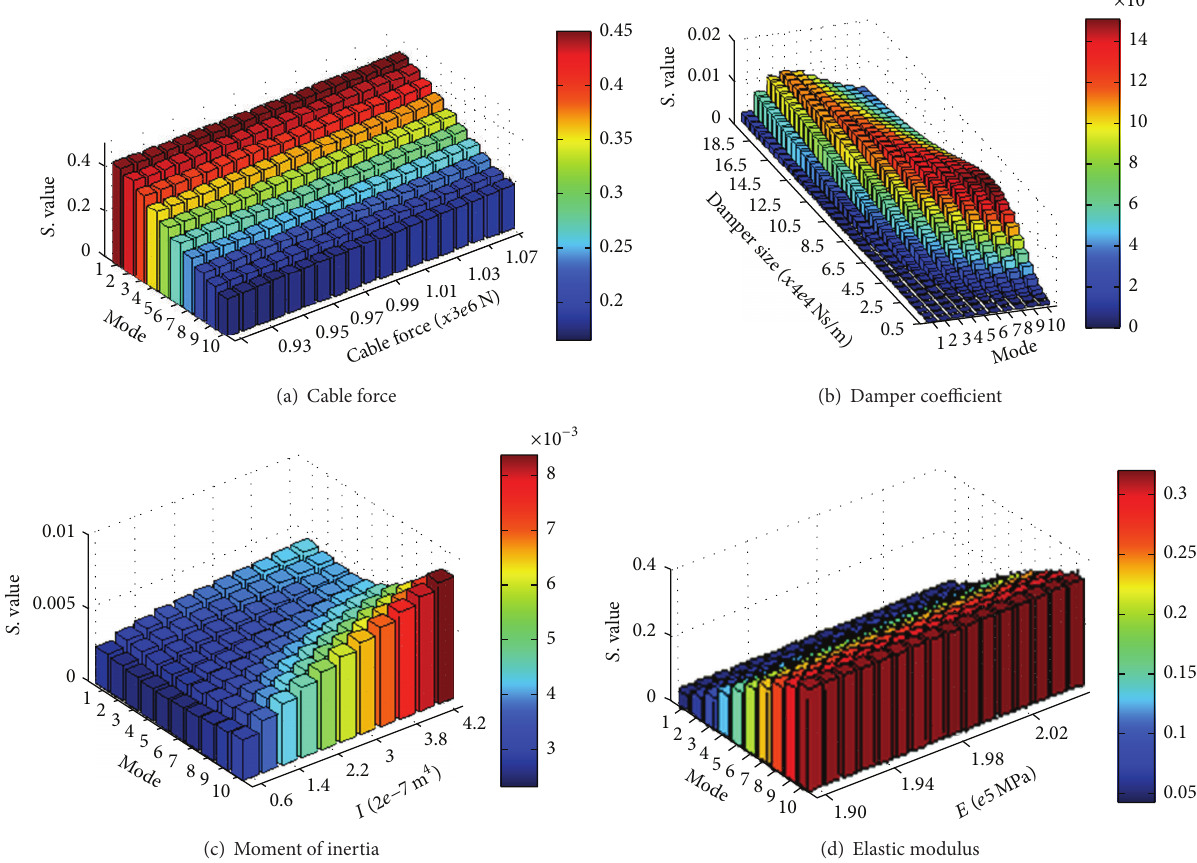
Figure 4: Sensitivity of first 10 modes of modal frequencies of cable to cable parameters.